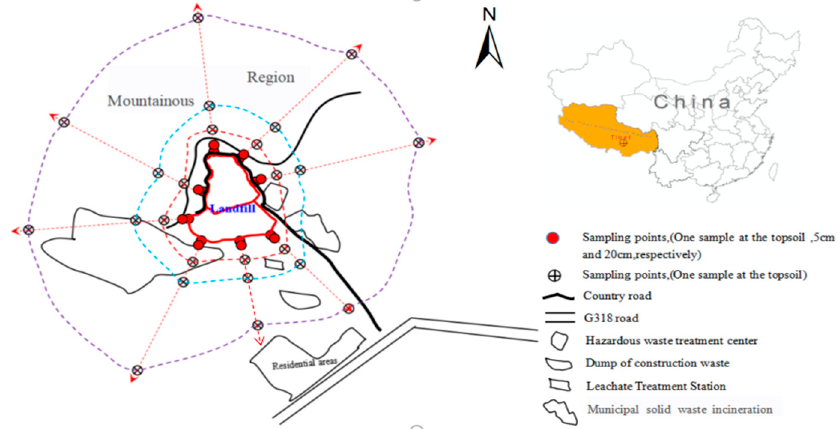
Figure 1. Location of the sampling sites around the domestic waste sanitary landfill site.